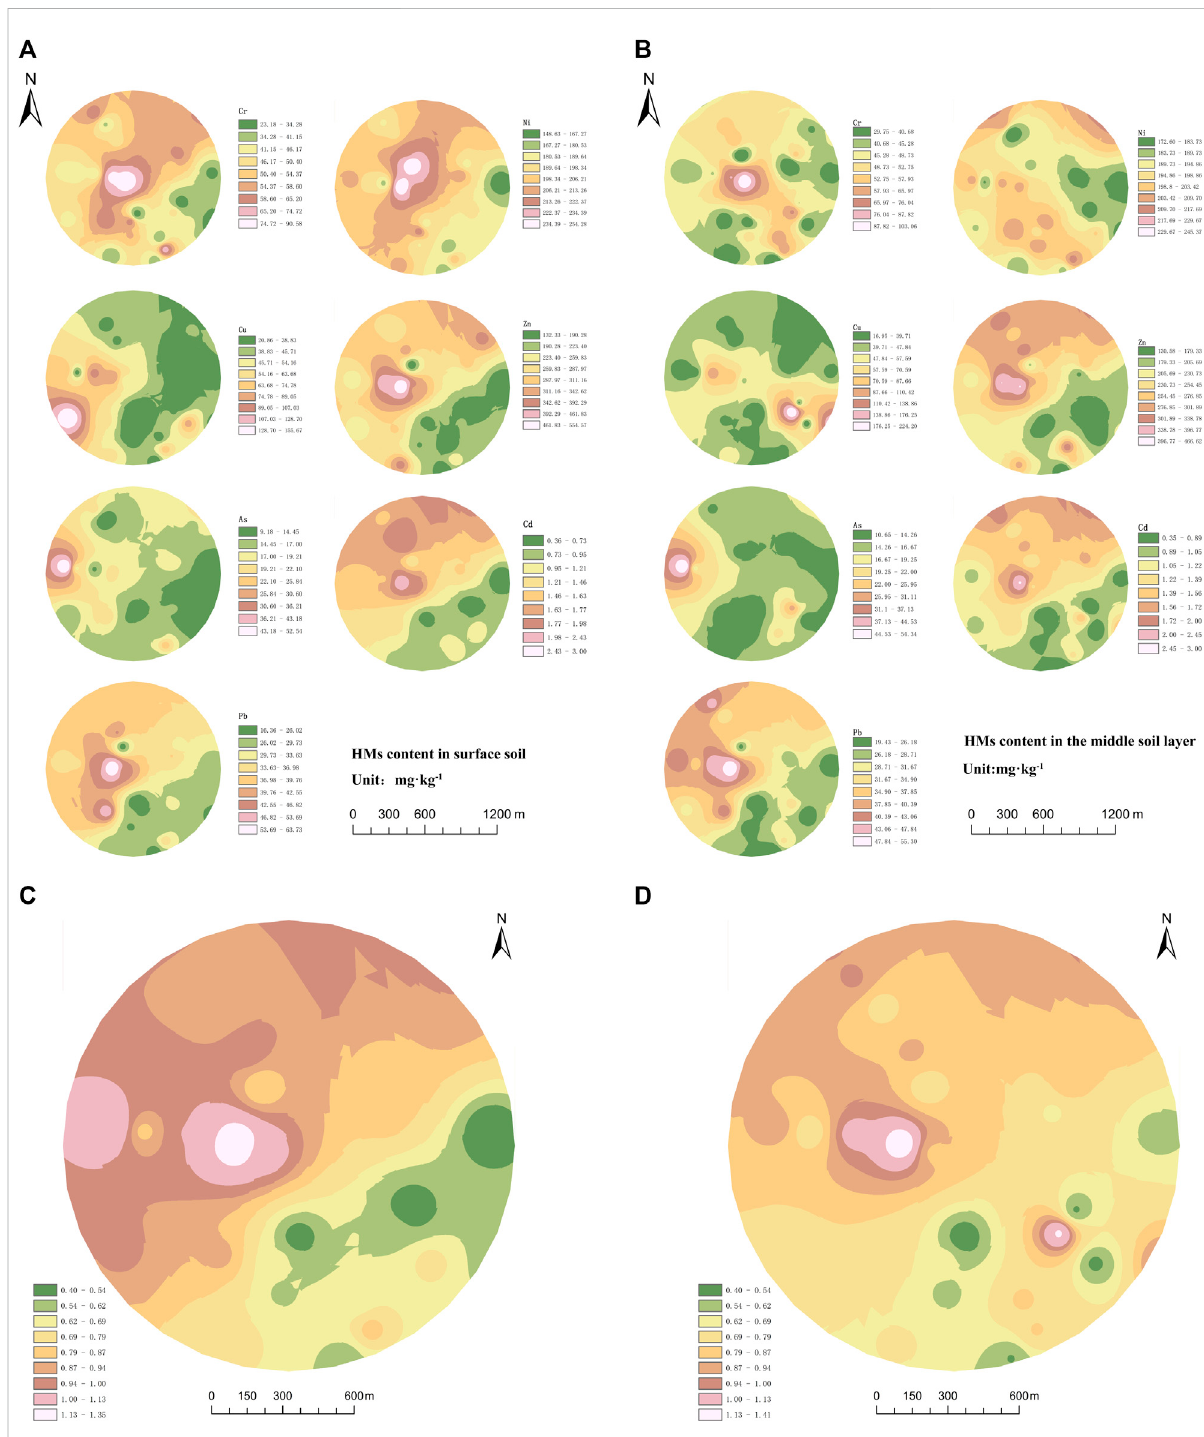
FIGURE 2 SpatialdistributionofSingle-factorpollutionindexandNemerocomprehensivepollutionindex. (A) Single-factorpollutionindexinsurfacesoil; (B) Single-factor pollution index in the middle soil layer; (C) Nemero comprehensive pollution index in surface soil; (D) Nemero comprehensive pollution index in the middle soil layer. *Stars represent the waste